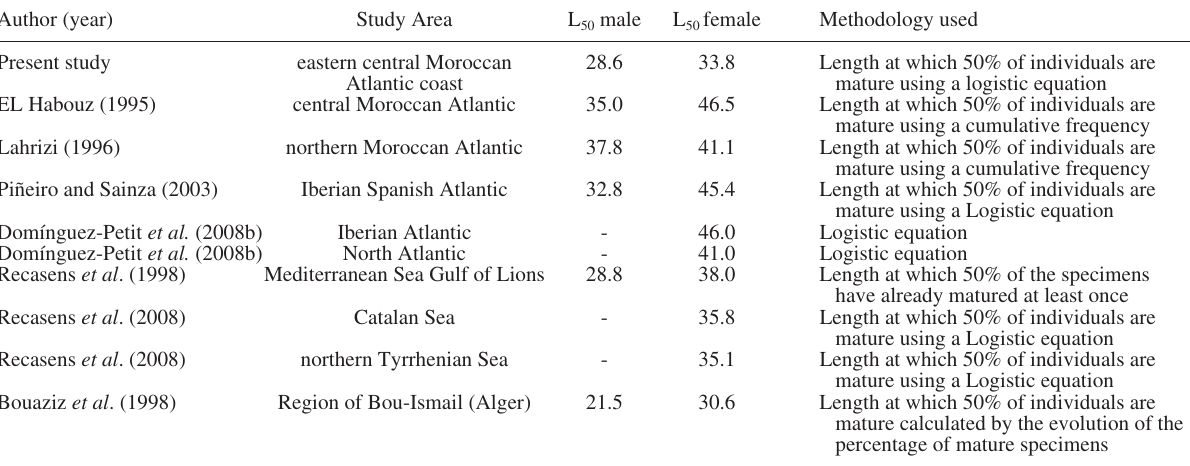
Table 5. – Size at first maturity (cm) for European hake from different geographic